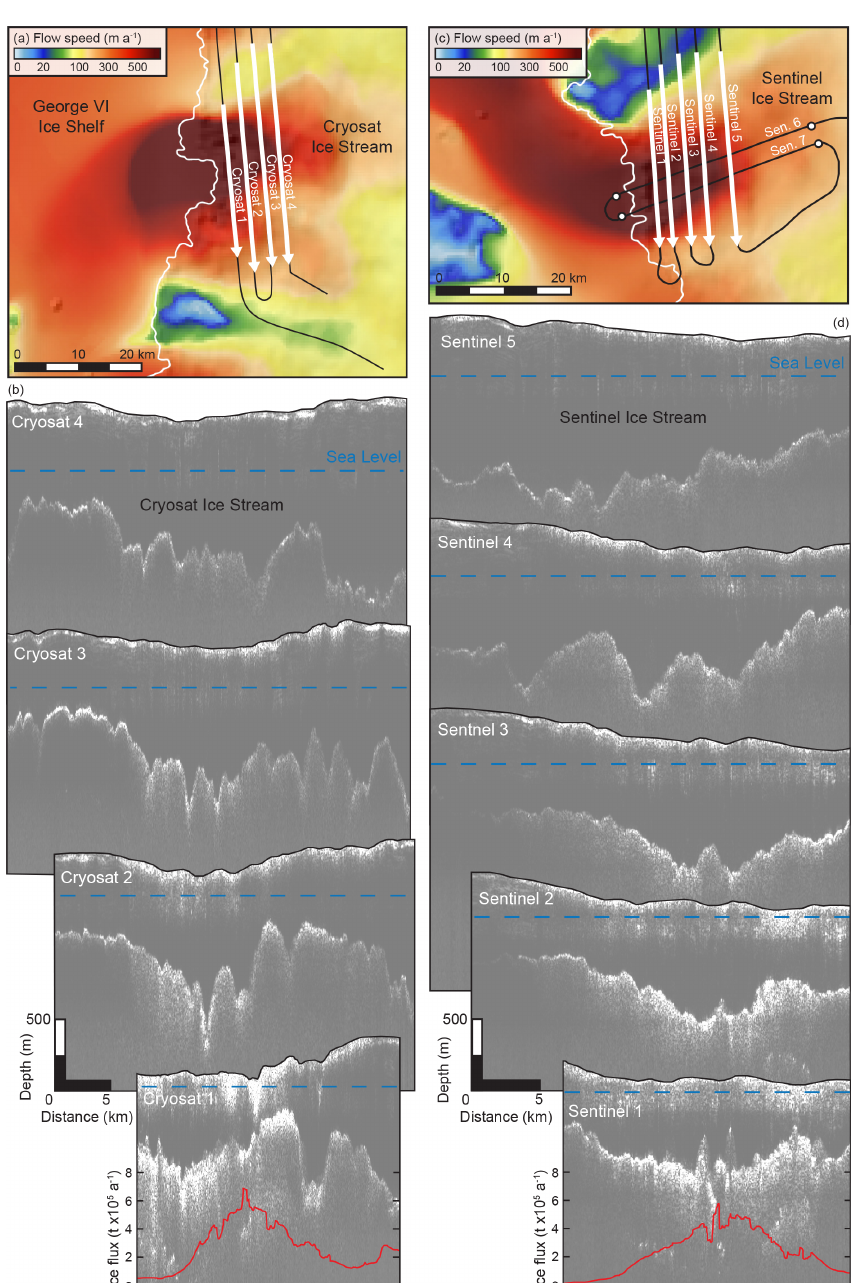
Figure 4. Radar investigations of Cryosat and Sentinel ice streams. Surface flow speed maps (Mouginot et al., 2019a) reveal the spatial variability in flow in panels (a) and (c) . These panels highlight the location of radargrams collected along the English Coast (black lines) as well as the direction and location of radargrams (white arrows) displayed in panels (b) and (d) . White lines indicate the ASAID grounding line (Bindschadler et al., 2011) whilst white circles in panel (c) represent the extent of along-flow radar transects presented in Fig. 7. Red lines in panels (b) and (d) show calculated ice flux along RES transects Cryosat 1 and Sentinel 1. Sea level is marked by a blue dashed